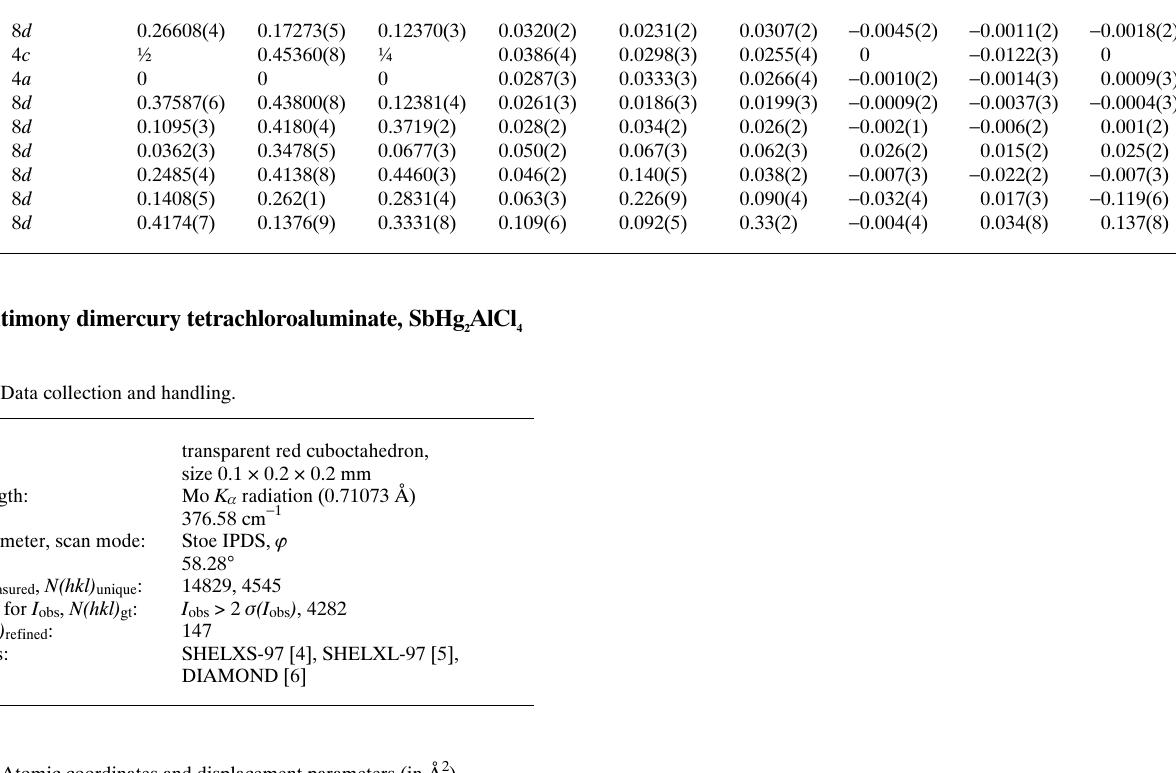
Table 4. Atomic coordinates and displacement parameters (in Å 2 )